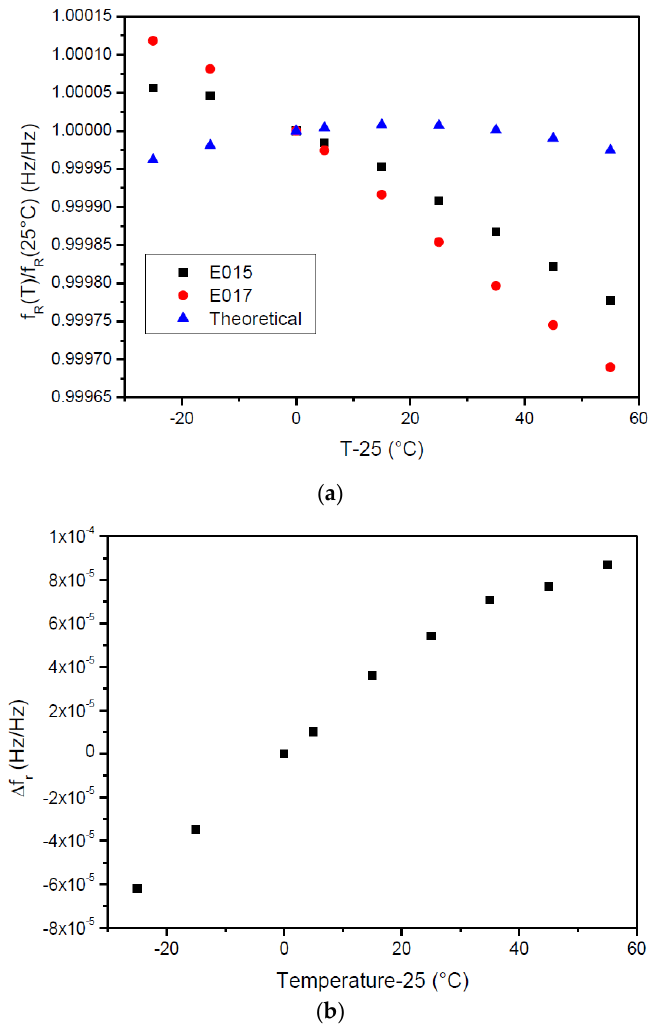
Figure 8. ( a ) Relative resonant frequency of gages SSE15 and SSE17 for different temperature values ∆𝑇 ; ( b ) ∆𝑓 𝑟 obtained for different temperature values ∆𝑇 .